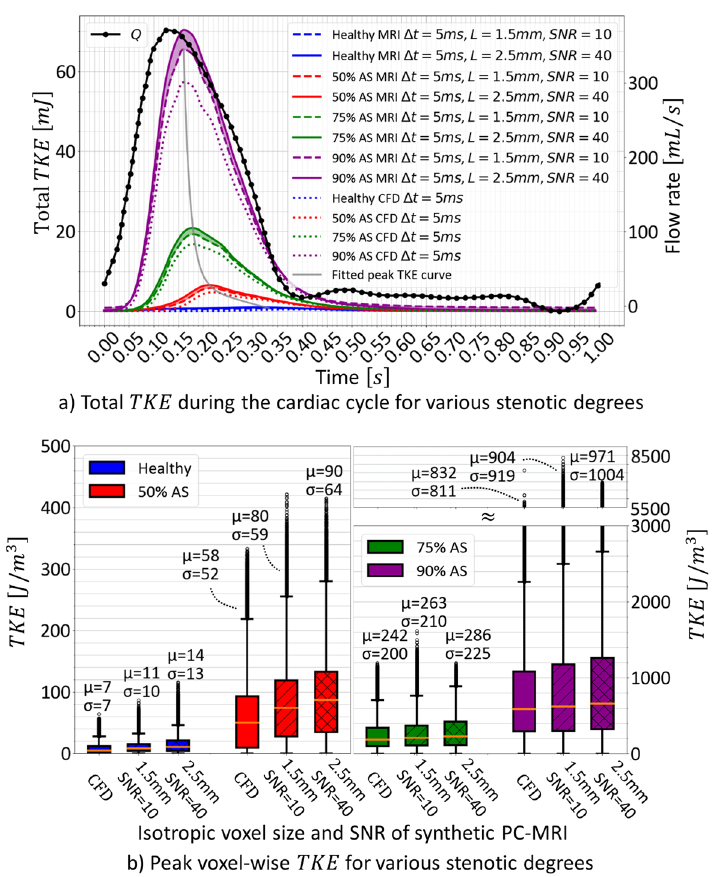
during the cardiac cycle for a healthy inlet flow and simulated aortic stenosis degrees of 50%, 75% and 90%. Note the temporal lag between peak flow rate and peak TKE represented by the fitted peak TKE curve. ( b ) Mean µ and standard deviation σ of peak voxel-wise TKE for the two resolutions of PC-MRI for healthy flow and 50%, 75% and 90%